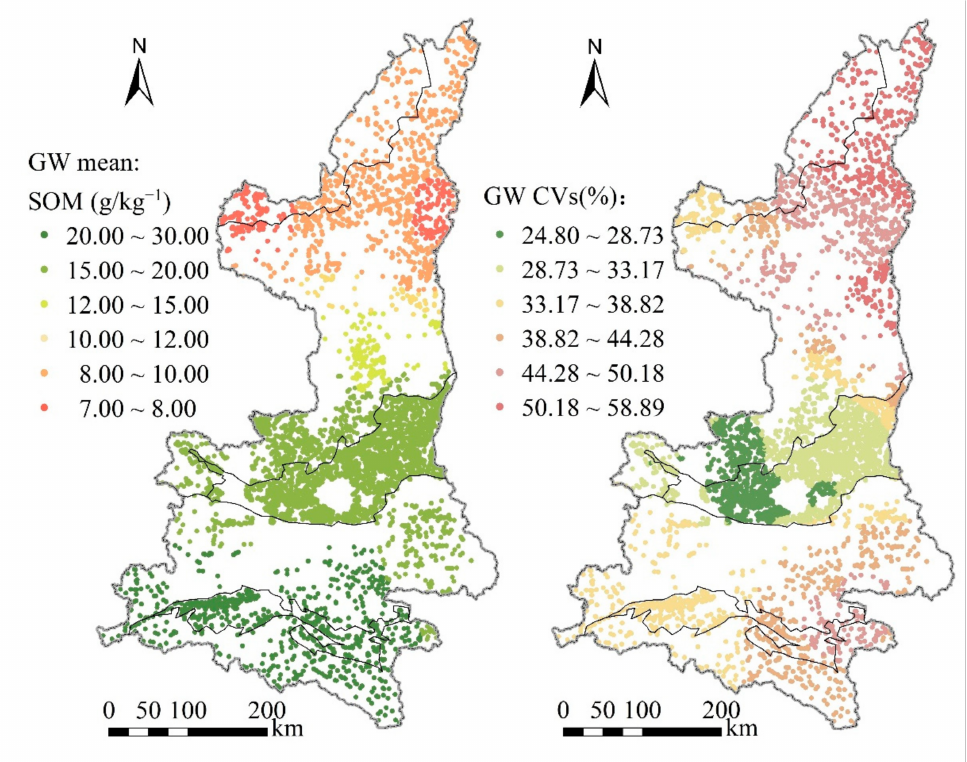
Figure 2. GW summary statistics for